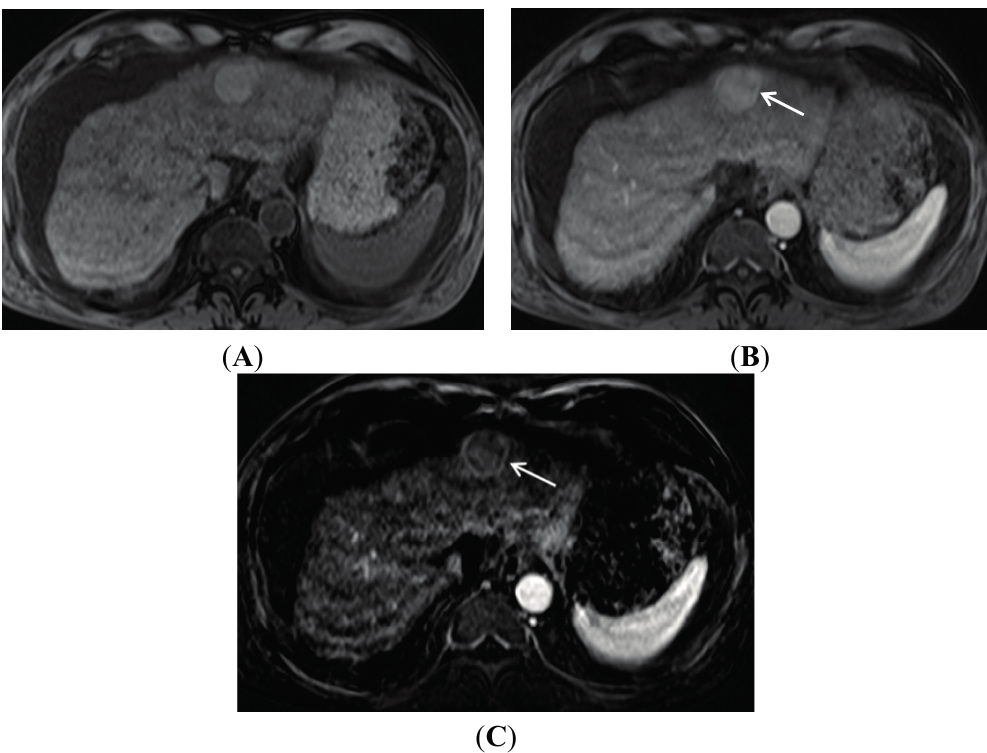
Figure 2. Importance of image subtraction in display of enhancement. ( A ) A T1 hyperintense hepatic nodule (arrow) is present on the pre-contrast image; ( B ) A late arterial phase gadolinium enhanced T1 gradient echo image demonstrates a bright nodule (arrow) suspicious for arterial enhancement; ( C ) On the subtraction image, the true, mild, enhancement of the nodule (arrow) is